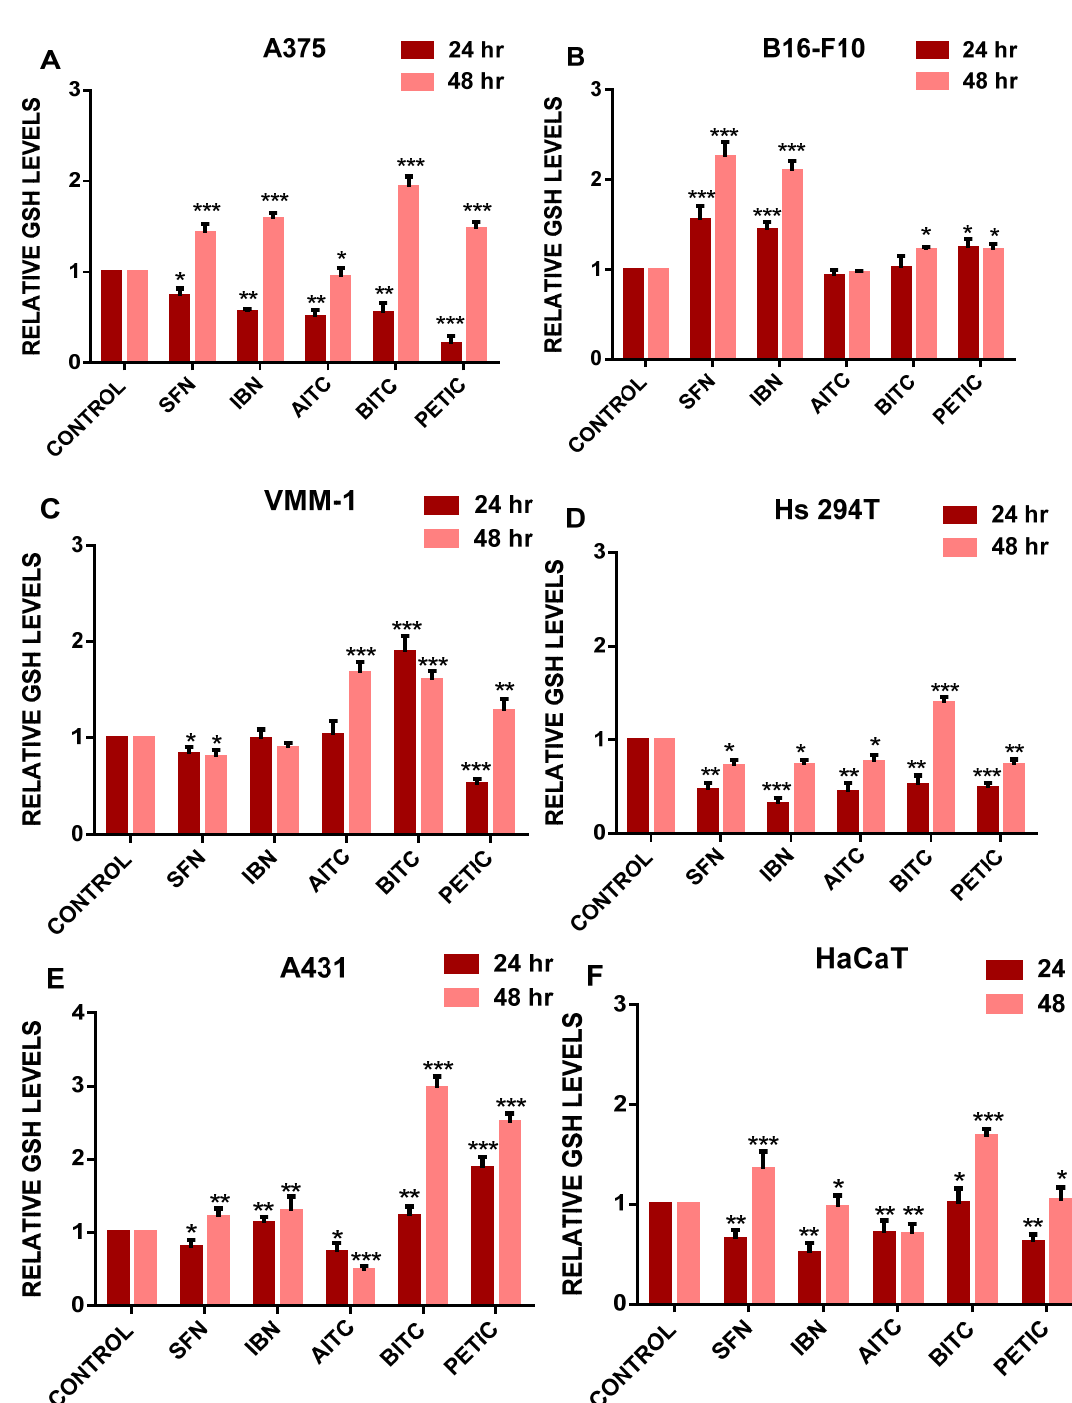
Figure 3. The effect of various ITCs on GSH levels in an in vitro model of MM. Cells were exposed to 10 µ M of each ITC, for 24 and 48 h, and monitored by means of flow cytometry. Results were quantitated as relative GSH levels for ( A ) A375, ( B ) B16F-10 ( C ) VMM1, ( D ) Hs294T, ( E ) A431 and ( F ) HaCaT cells. Data shown are means ± SD of three replicates from three independent experiments. * p < 0.05, ** p < 0.01, *** p < 0.001, when compared to untreated (control)